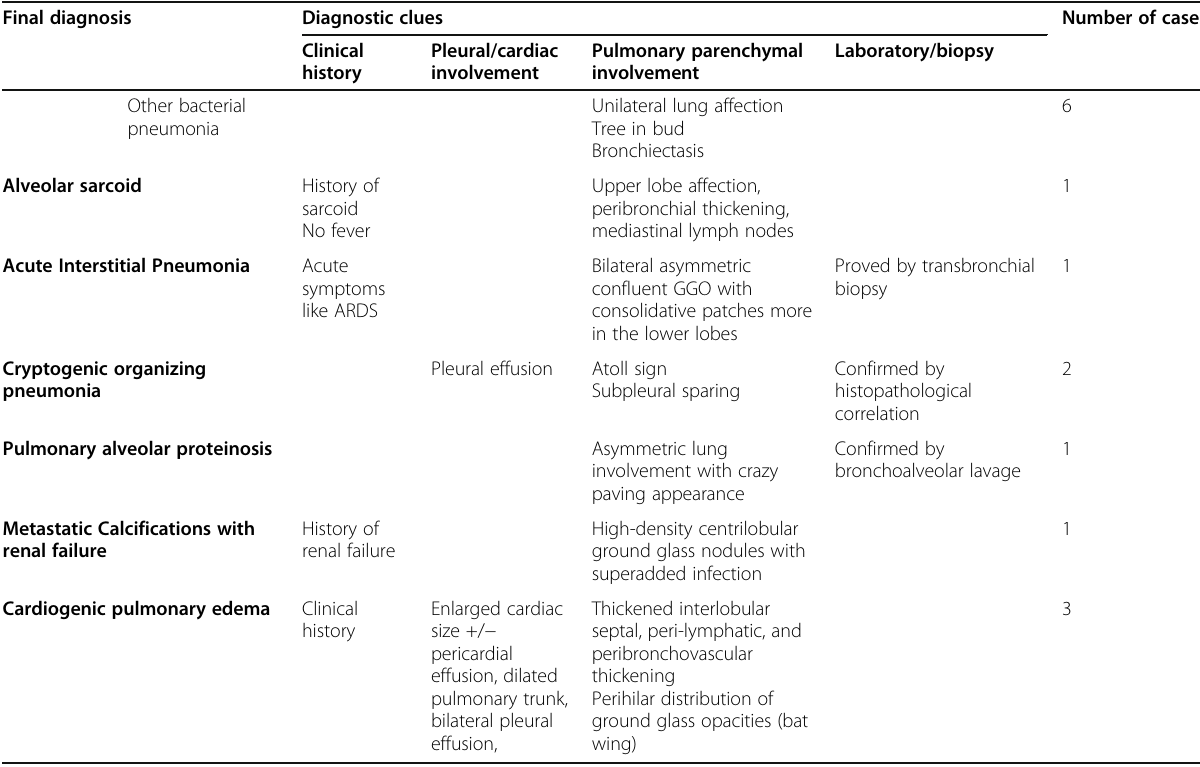
Table 5 Diagnostic clues for COVID-19 mimicker (Continued)